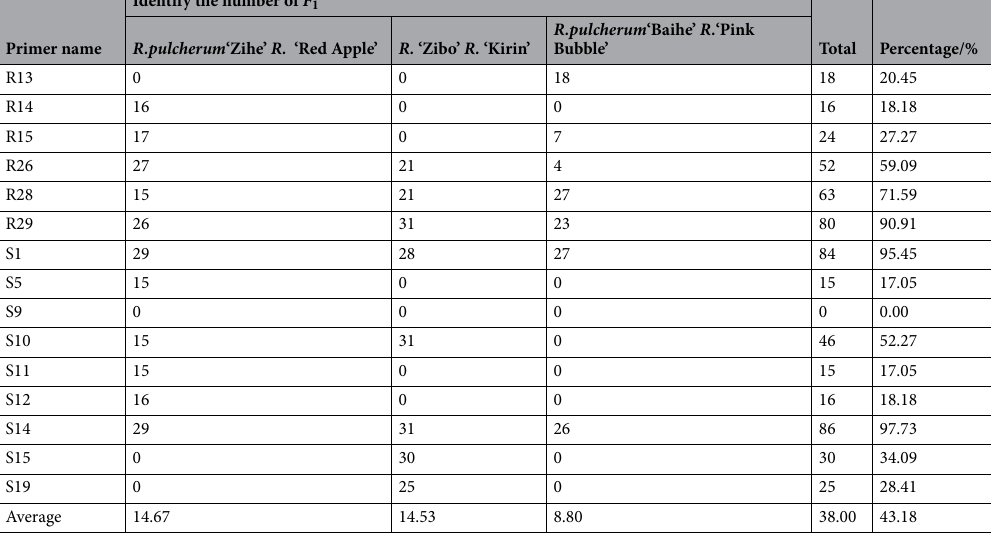
Table 5. 15 Statistics on the number of EST-SSR azaleas.